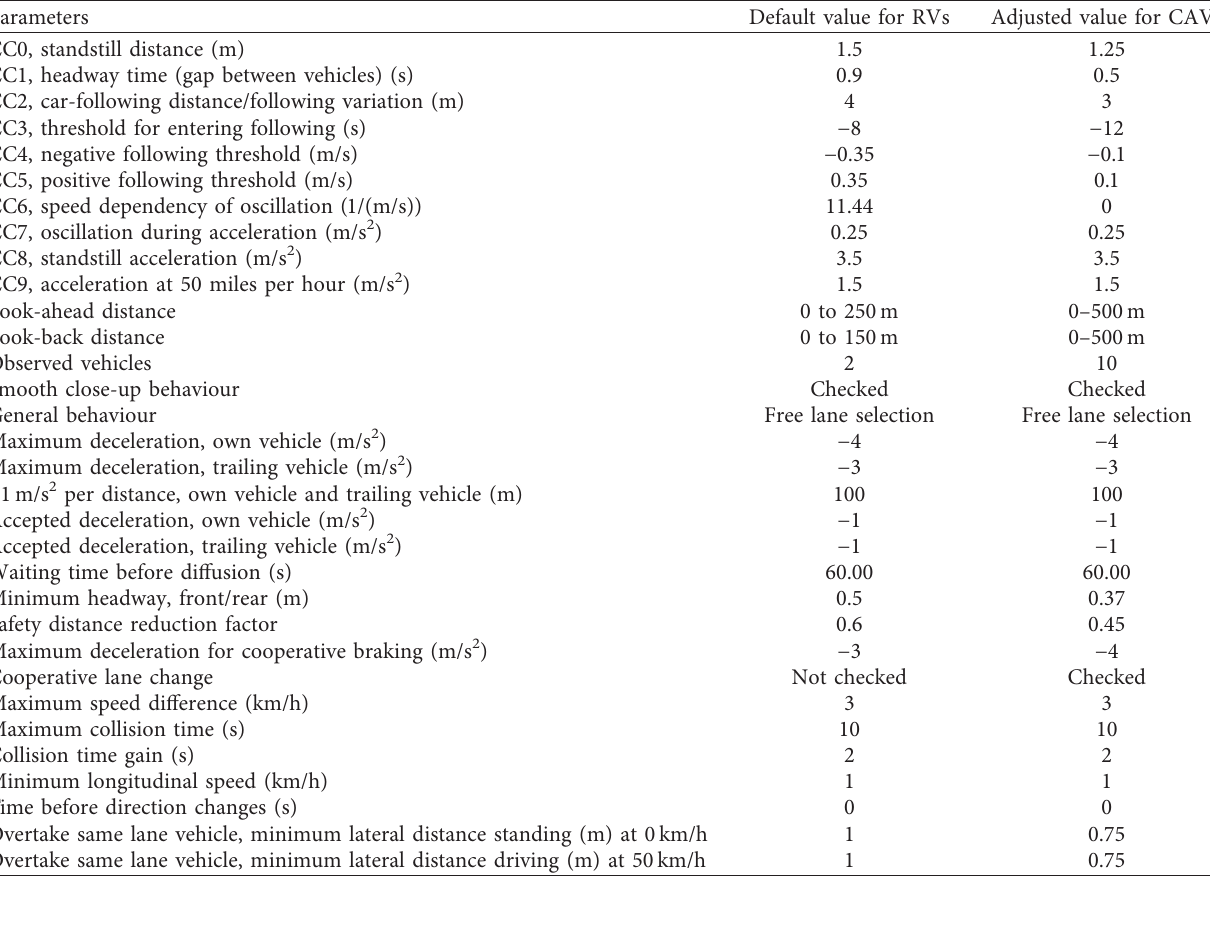
Table 2: Car-following and lane-change parameters of RVs and CAVs in this study.